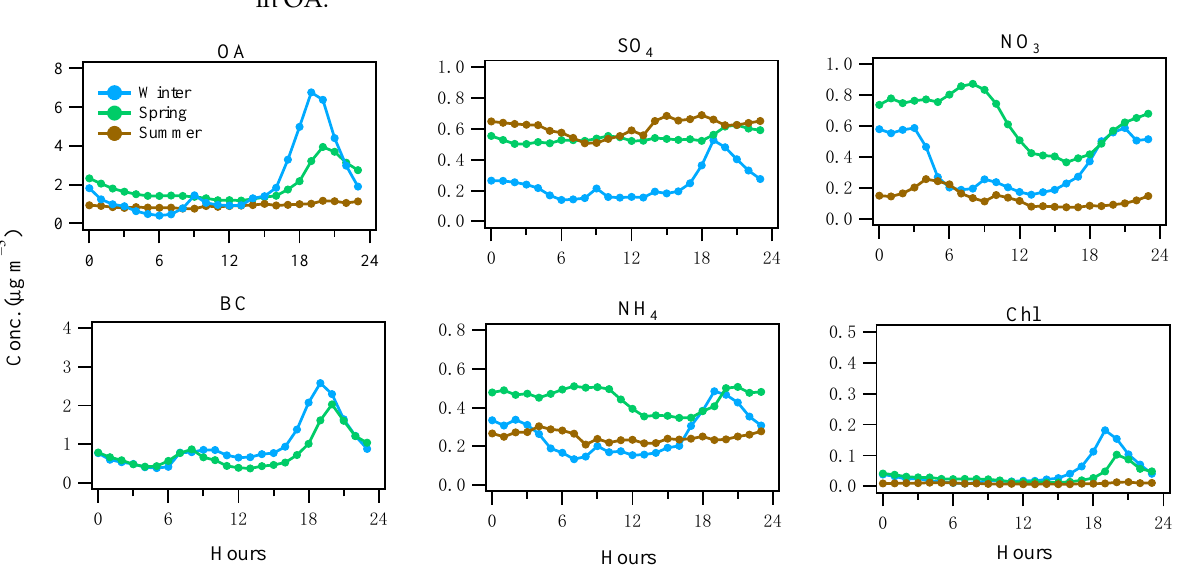
Figure 2. Diurnal cycles of the NR-PM 1 species, i.e., organics (OA), sulfate (SO 4 ), nitrate (NO 3 ), ammonium (NH 4 ), and chloride (Chl), as well as BC over winter, spring, and summer 2016. Note that BC measurements were only available in winter and spring.